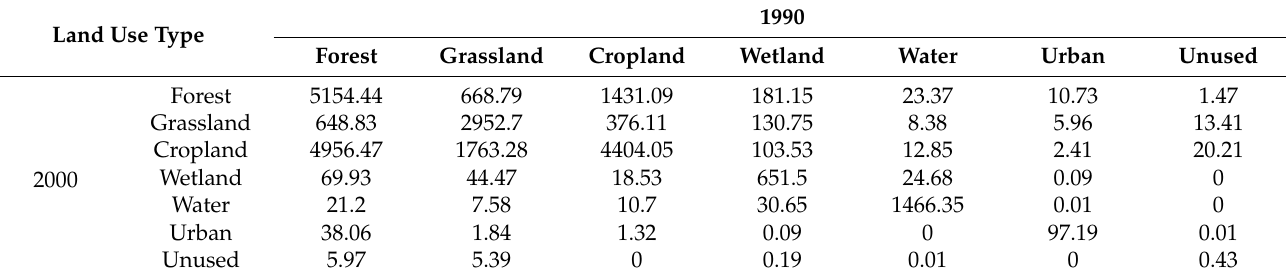
Table A2. Transfer matrix of land use types in Rwanda from 1990 to 2000 (km 2 ). Land Use